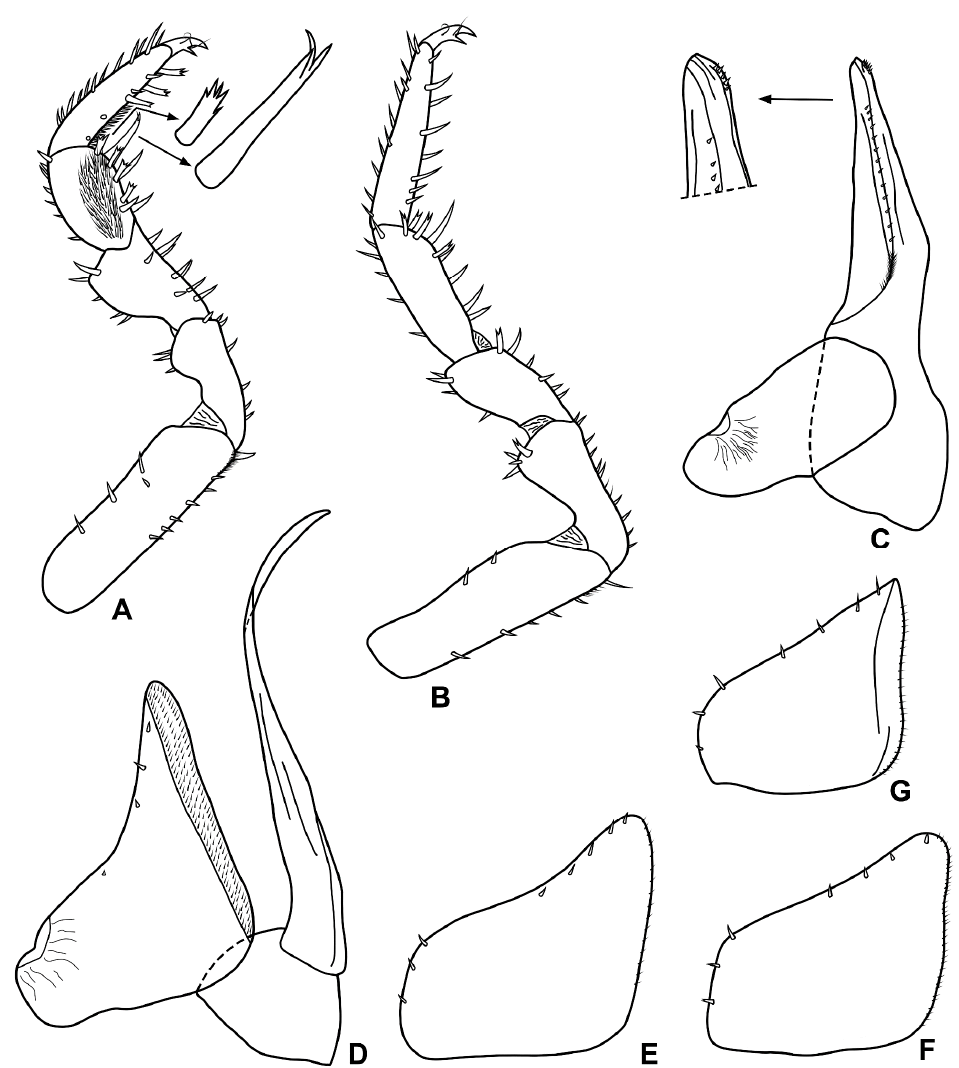
Figure 15. Alloschizidium segestanum sp. n., paratype ♂ from Punta Manara. ( A ) Pereopod 1. ( B ) Pereopod 7. ( C ) Pleopod 1. ( D ) Pleopod 2. ( E ) Pleopod 3 exopod. ( F ) Pleopod 4 exopod. ( G ) Pleopod 5 exopod.